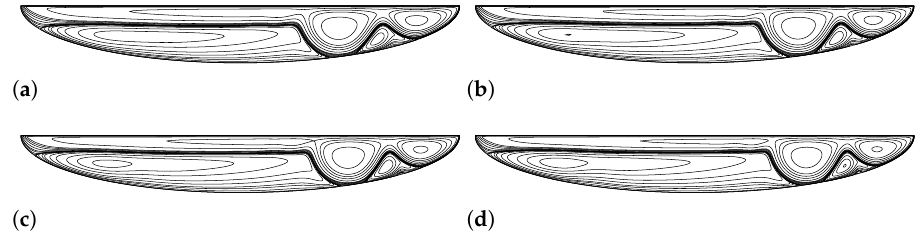
Figure 11. The evolution of the 2nd solution of driven semi-elliptical cavity flow above Re = 16,000 for D = 0.26 aspect ratio. ( a ) Re = 17,000 (2nd solution). ( b ) Re = 19,000 (2nd solution). ( c ) Re = 21,000 (2nd solution). ( d ) Re = 23,000 (2nd solution).